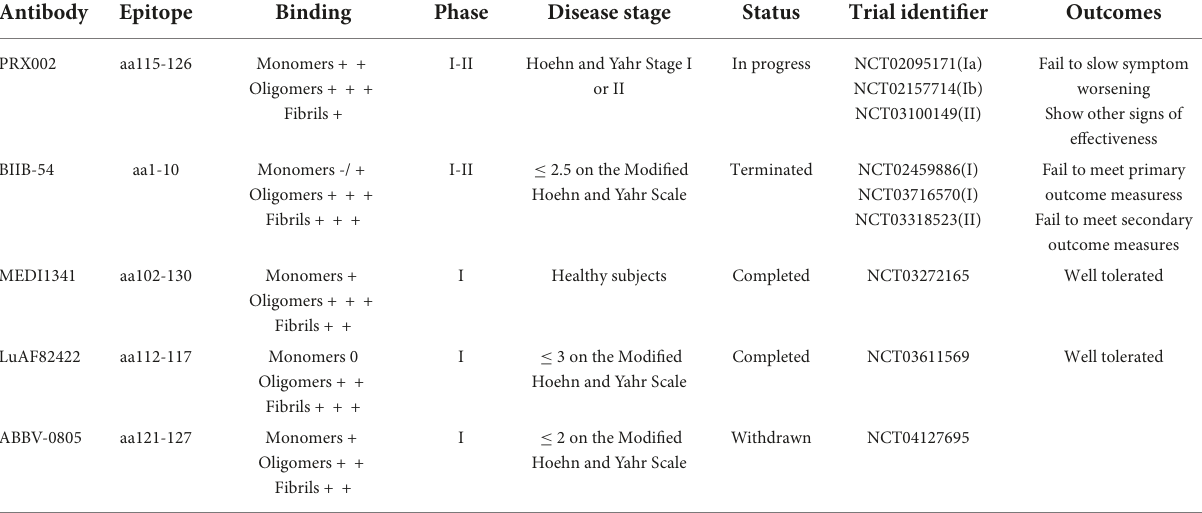
TABLE 1 α -Synuclein-based passive immunotherapies involved in clinical trials for Parkinson’s disease.